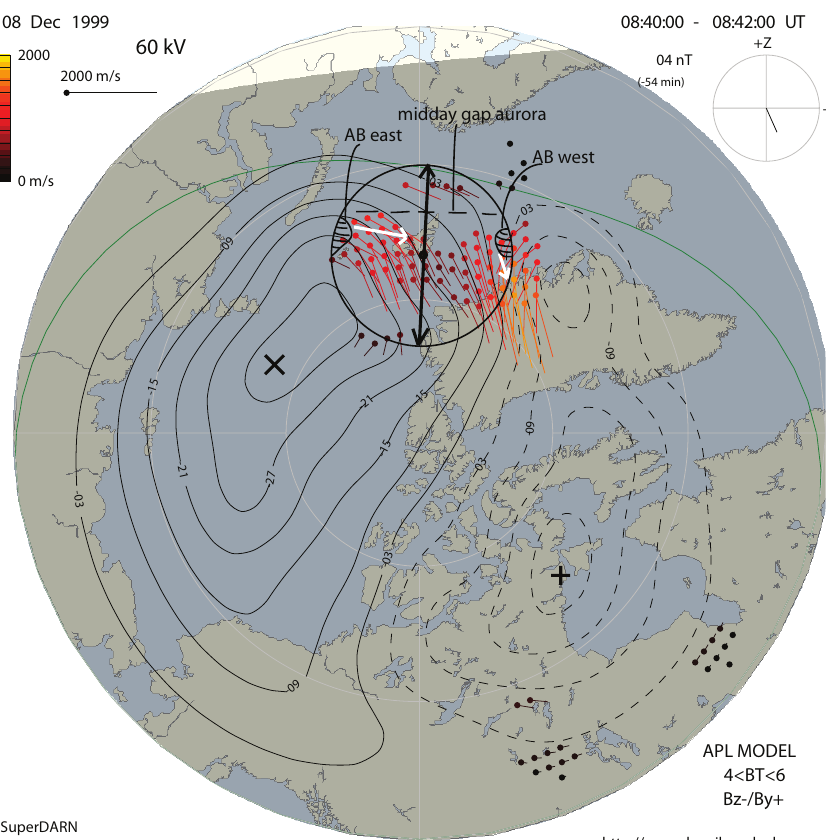
Fig. 12. SuperDARN plasma convection data for 08:40–08:42 UT on 8 December 1999. Same format as in Fig. 4. The ASC (circle) and MSP fields of view and auroral brightening events at the eastern (AB east) and western (AB west) boundaries of the ASC FOV have been marked. Auroral expansions in PMAFs/prenoon and PMAFs/postnoon are marked by white